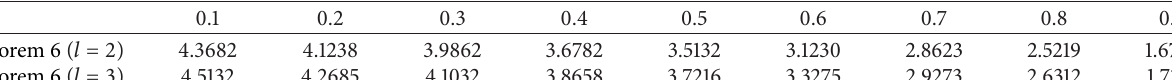
Table 2: Maximum allowable time-delay bounds ℎ = 𝑟 for different values ℎ 𝐷 in Example 1.